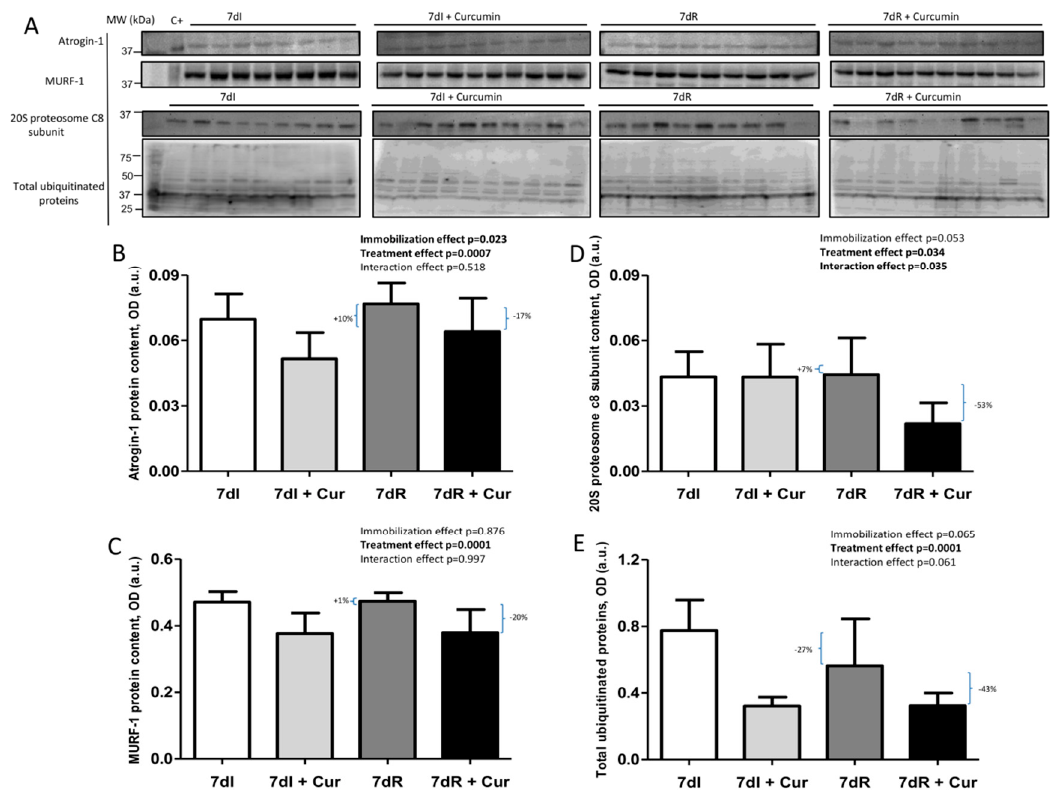
Figure 5. ( A ) Representative immunoblots of atrogin-1, MuRF-1, 20S proteasome alpha subunit C8 and total ubiquitinated proteins in the gastrocnemius muscle of all study groups of mice. Definition of abbreviations : MuRF-1, muscle RING-finger protein-1; C+, positive control; MW, molecular weight; kDa, kilodalton; I, immobilization; R, recovery. ( B ) Mean values and standard deviation of atrogin-1 protein content in the gastrocnemius muscle of the different study groups of mice, as measured by optical densities in arbitrary units (OD, a.u.). Definition of abbreviations: OD, optical densities; a.u., arbitrary units; I, immobilization; R, recovery; Cur, curcumin. The statistical analyses (two-way ANOVA test) of the effect of immobilization, treatment and interaction effects, are also indicated as actual P values for each variable. The percentage of change between: 1) 7dR and 7dI and 2) 7dR + Curcumin and 7dR are also indicated for each variable. ( C ) Mean values and standard deviation of MuRF-1 protein content in the gastrocnemius muscle of the different study groups of mice, as measured by optical densities in arbitrary units (OD, a.u.). Definition of abbreviations: MuRF-1, muscle ring finger protein 1; OD, optical densities; a.u., arbitrary units; I, immobilization; R, recovery; Cur, curcumin. The statistical analyses (two-way ANOVA test) of the effect of variable. The percentage of change between: 1) 7dR and 7dI and 2) 7dR + Curcumin and 7dR are also